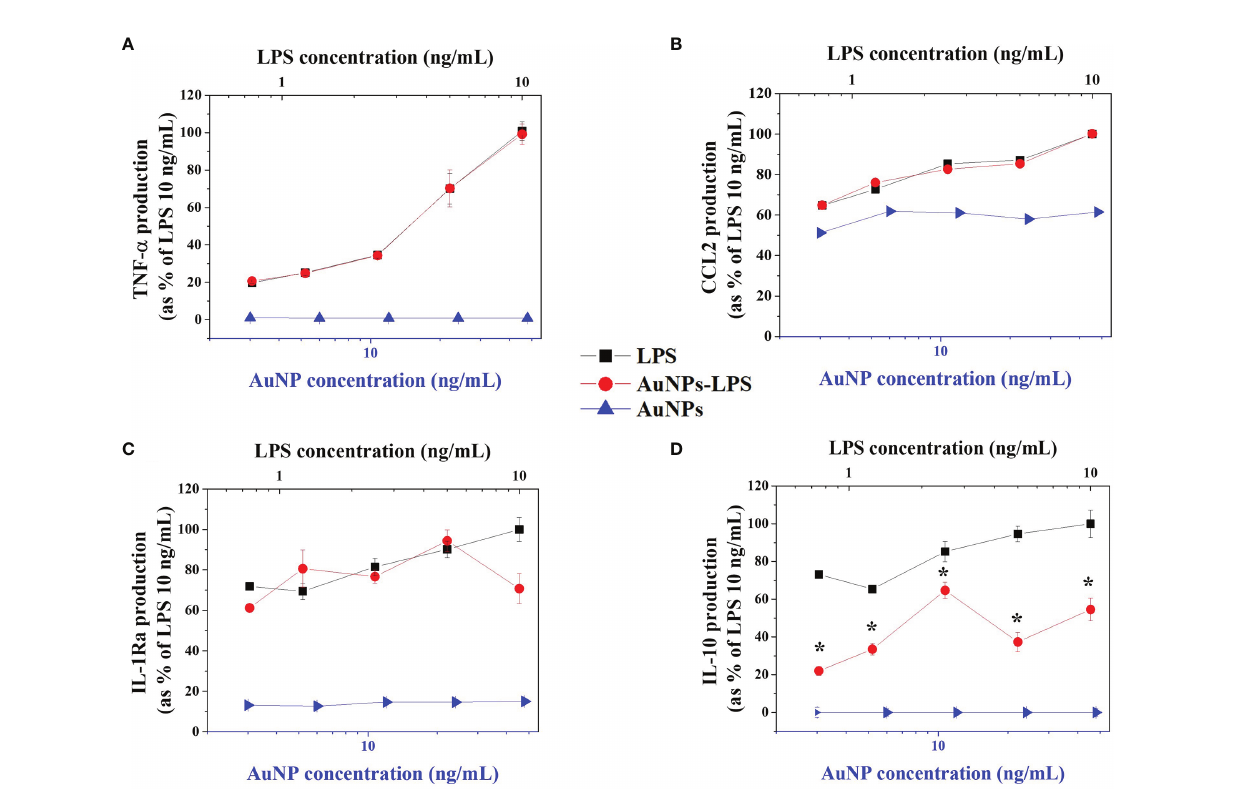
FIGURE 4 | Macrophage activation by LPS-coated AuNPs. Human monocyte-derived macrophages were treated for 24 h with free LPS (black squares), bare (AuNPs; blue triangles) and LPS-coated AuNPs (AuNPs-LPS; red dots). The production of TNF- a (A) , CCL2 (B) , IL-1Ra (C) and IL-10 (D) was measured in the culture supernatants by ELISA and normalized as percentage of the maximum value (cytokine levels produced in response to 10 ng/mL LPS). Cytokine concentration ranges were: 0.08-9.40 ng/mL for TNF- a ; 0.18-0.38 ng/mL for CCL2; 10.23-78.0 ng/mL for IL-1Ra; 0.28-1.27 ng/mL for IL-10. Results are reported as mean ± SD of data from 3 independent experiments performed on cells from 3 individual donors. * p < 0.01 LPS vs . LPS-AuNPs (Student ’ s t